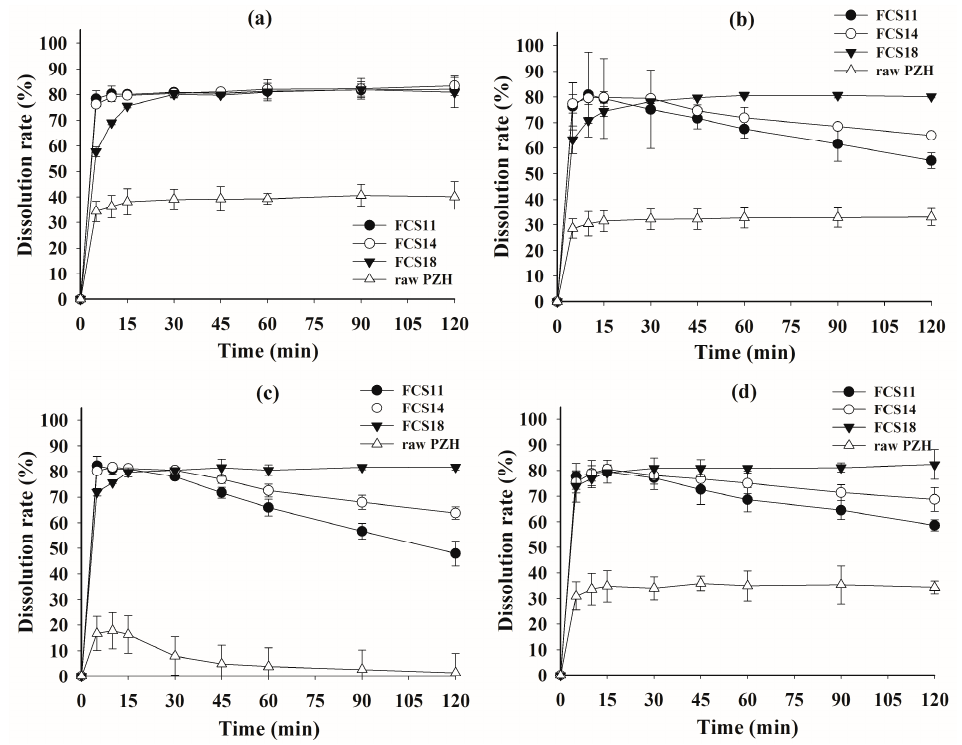
Figure 6. Dissolution profiles of FCS formulations and raw PZH in pH 1.2 buffer ( a ), pH 4.0 buffer ( b ), pH 6.8 buffer ( c ), and water ( d ). pH 6.8 buffer ( c ), and water ( d